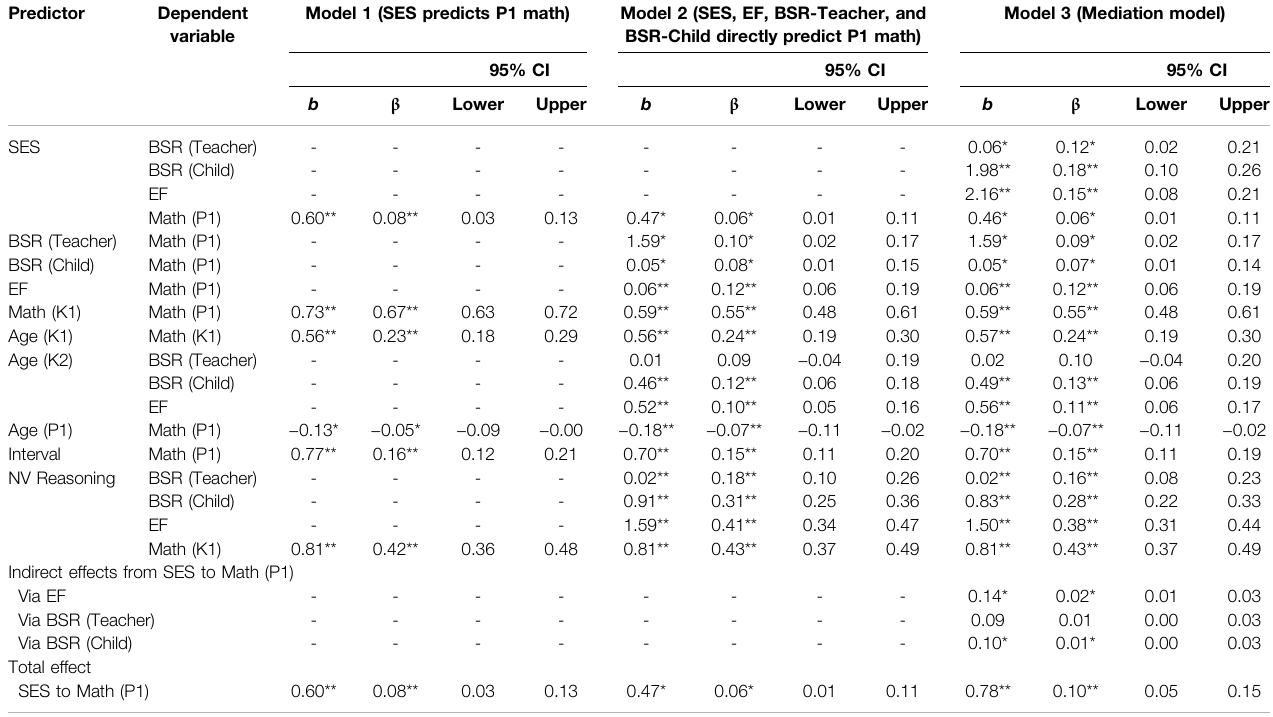
TABLE 2 | Results of path analyses.